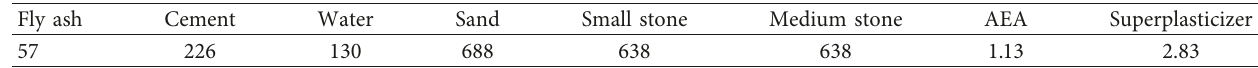
Table 8: BFRC proportion (kg).